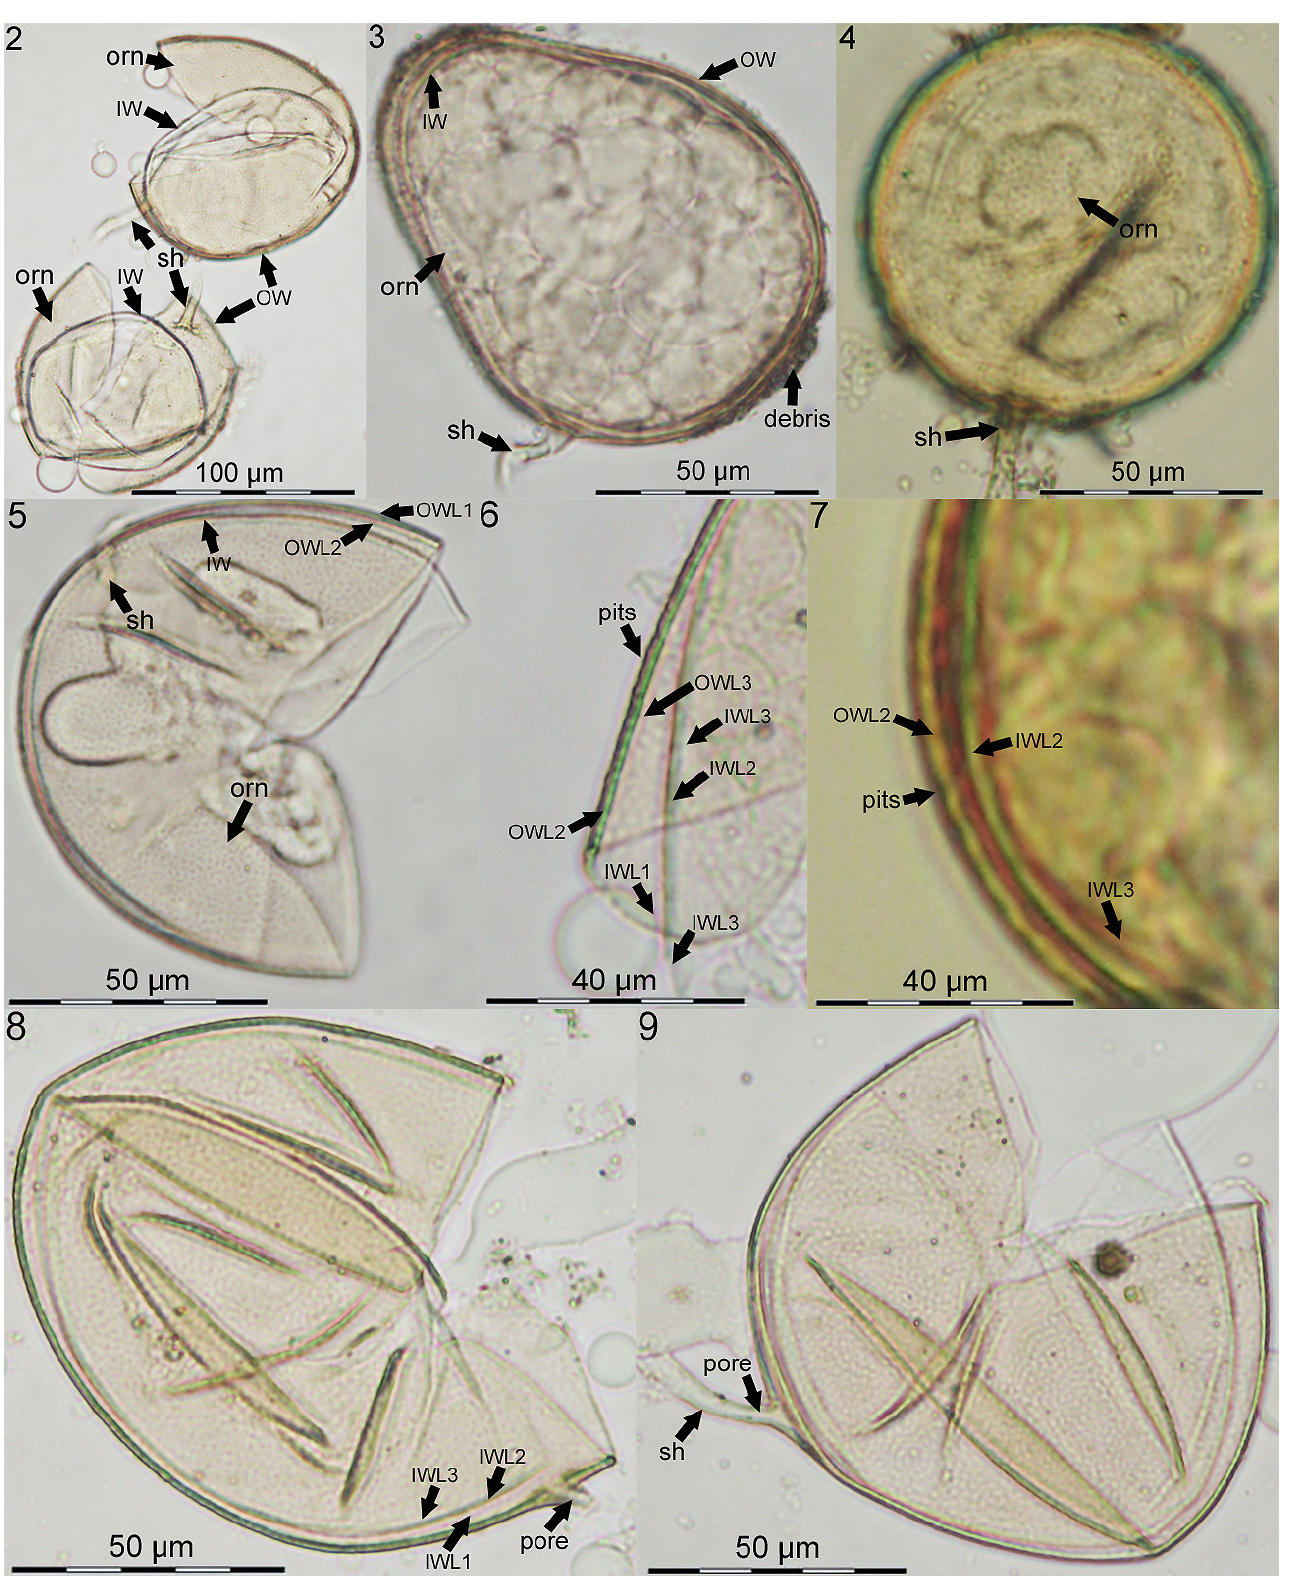
Figs. 2-9: Paraglomus pernambucanum : Figs. 2-3. Crushed and uncrushed spores with outer and inner wall (OW, IW), cylindric to funnel-shaped subtending hyphae (sh) and minute pit ornamentation on OW surface. Fig. 4. Outer wall staining yellow in Melzer’s reagent. Figs. 5-6. OW and IW triple-layered (OWL1-3; IWL1-3); outer surface of OWL2 with minute pits. Fig. 7. OWL2 staining yellow in Melzer’s. Figs. 8-9. Pore at spore base regularly open but closed by